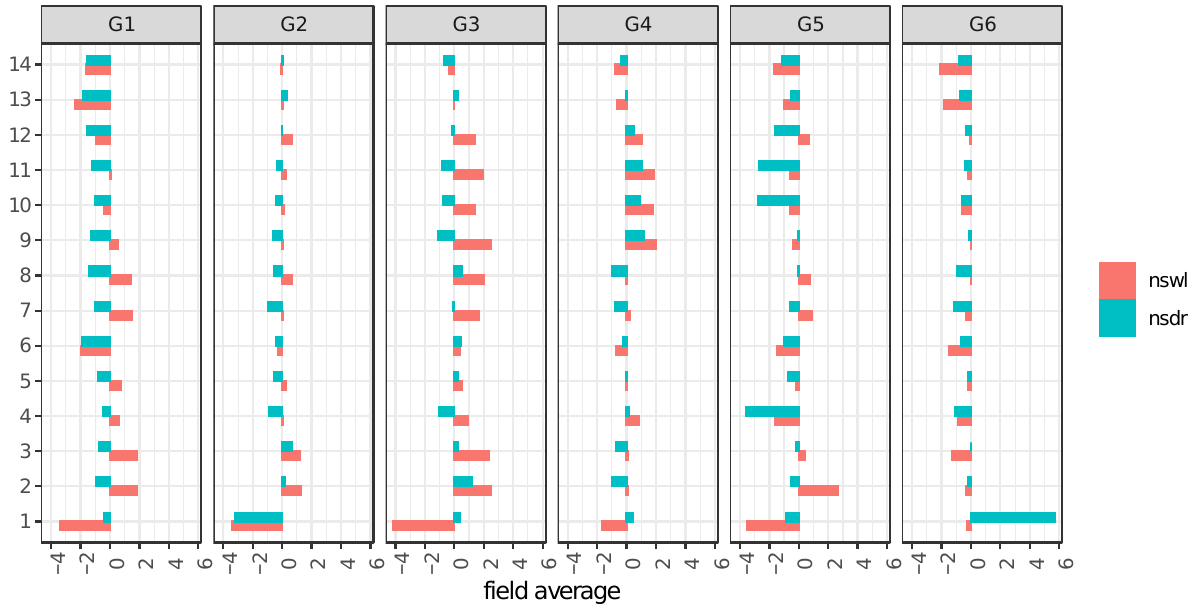
Figure 5. The bar plot presenting averaged (over all three fields) fold change (FC) between two comparisons, such as conditions no stress (ns) vs. waterlogging (wl) and drought stress (dr), respectively, for field a. The red bars represent ns vs. wl, and blues bar show FC between ns vs. dr, left side negatively/down- and right side positive/up-regulated.